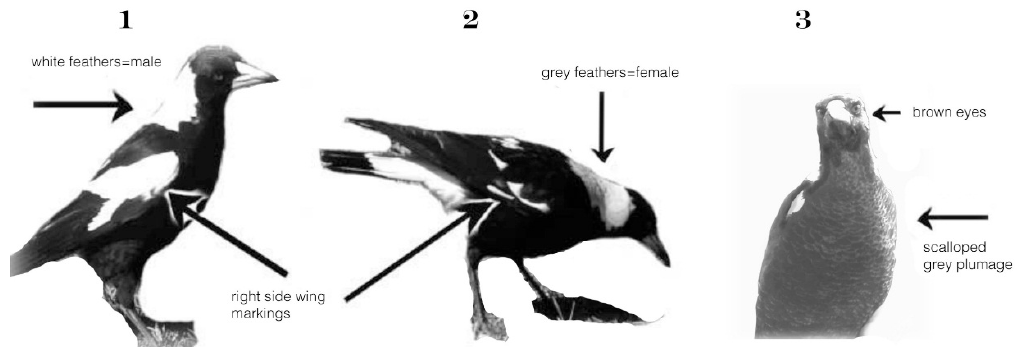
Figure 7. Identifying magpies in the field is generally simple. Wing-markings are obvious, individually distinctive, and unchanging over the lifespan (see lower arrows in 1 and 2). ( 1 ) Shows an adult male, identifiable by the clear white feathers at the back of the neck; ( 2 ) is an adult female, the only difference in plumage is a small strip of grey (as per arrow) at the nape of the neck; and ( 3 ) is a juvenile with greyish scalloped plumage. Adult plumage overall is black, interspersed with white. Note that wing markings in adults and also in juveniles (no separate juvenile stage for tail and wing feathers) are individually specific. Juveniles are distinguished by darkish brown eyes (adults have light brown to reddish eyes). Juveniles cannot be sexed by plumage.